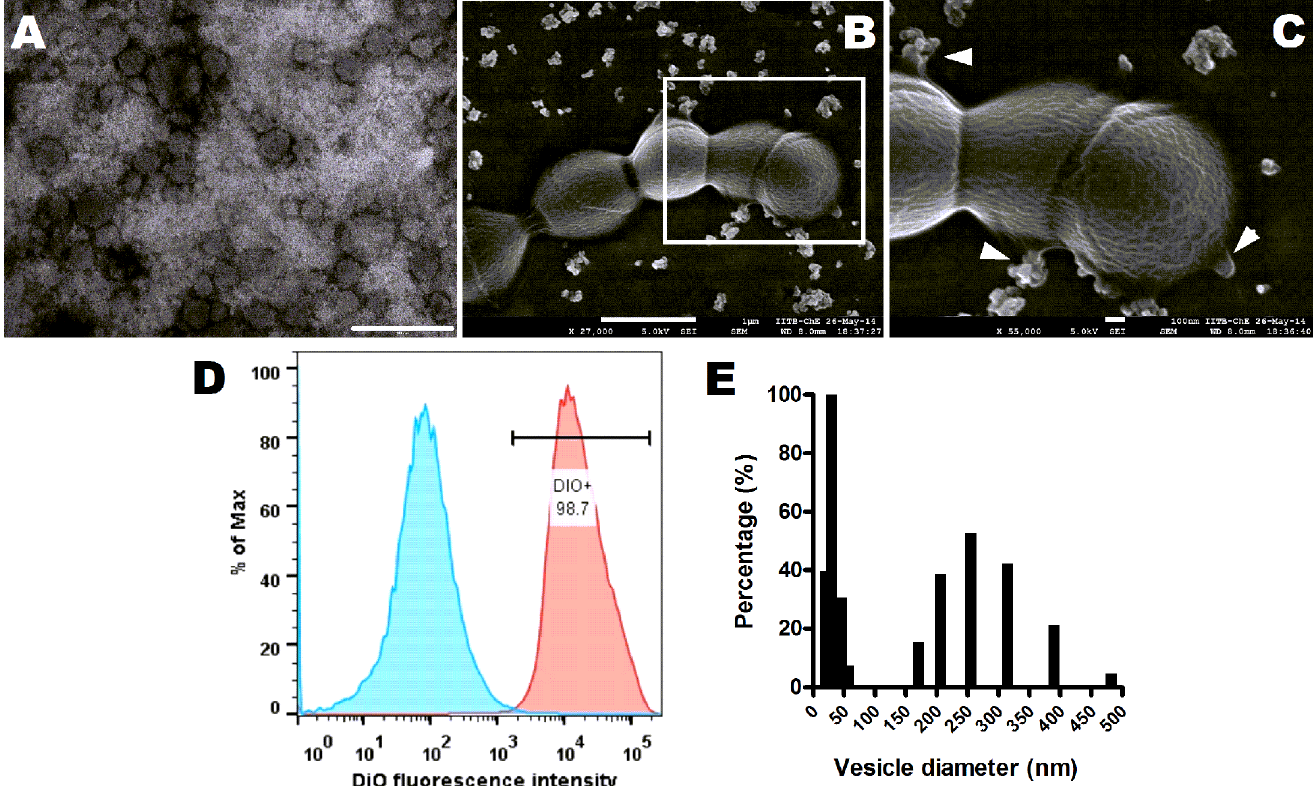
Fig 1. GBS produces extracellular membrane vesicles. A. Representative transmission electron micrograph of membrane vesicles (MVs) isolated from GBS strain A909. Scale bar; 200 nm. B. Representative scanning electron microscopic image of GBS strain A909 exhibiting aggregated MVs dispersed around the cells and budding of MVs from GBS cells. Scale bar; 1 μ m. C. Zoomed in view of the boxed area in ( B ). Arrowheads indicate vesicles budding sites. Scale bar; 100 nm. D. Flow cytometry of isolated MVs stained with lipid specific dye, DiO. Blue shaded curve denotes unlabeled MVs and pink shaded curve depicts DiO labeled MVs. E. Size distribution of isolated MVs by Dynamic Light Scattering. Experiments were performed thrice and data from one representative experiment is shown. doi:10.1371/journal.ppat.1005816.g001 PLOS Pathogens | DOI:10.1371/journal.ppat.1005816 September 1,